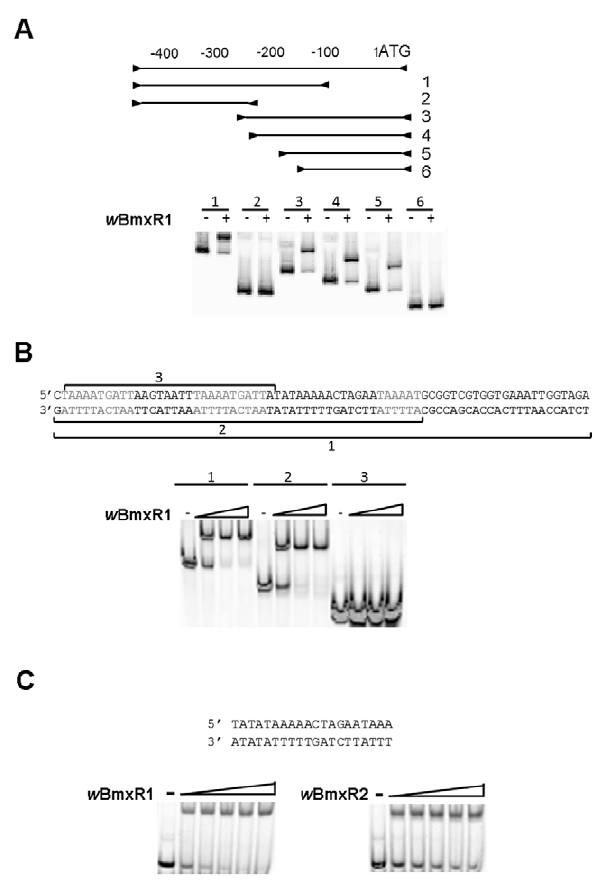
Figure 6. Identification of the minimal region upstream of ribA that binds w BmxR1. The minimal sequence of the ribA promoter region that binds w BmxR1 was identified an electrophoretic mobility shift assay (EMSA). (A) Six primer sets (A1 to A6 in Table 3) were used to generate six PCR products corresponding to various regions (from the ATG start site of ribA to 469 bp) upstream of the ribA promoter. Each PCR product was incubated with ( + ) or without ( 2 ) protein and loaded onto a 6% DNA retardation gel. (B) Three synthesized 5 9 FAM-labeled oligos (sequence shown) were annealed to dsDNA and used to shift w BmxR1. (C) w BmxR2 also shifts the minimum binding sequence for w BmxR1 in EMSA.